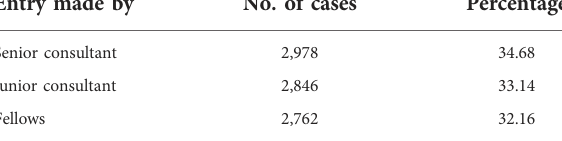
TABLE 6 Entry made through Jain point.